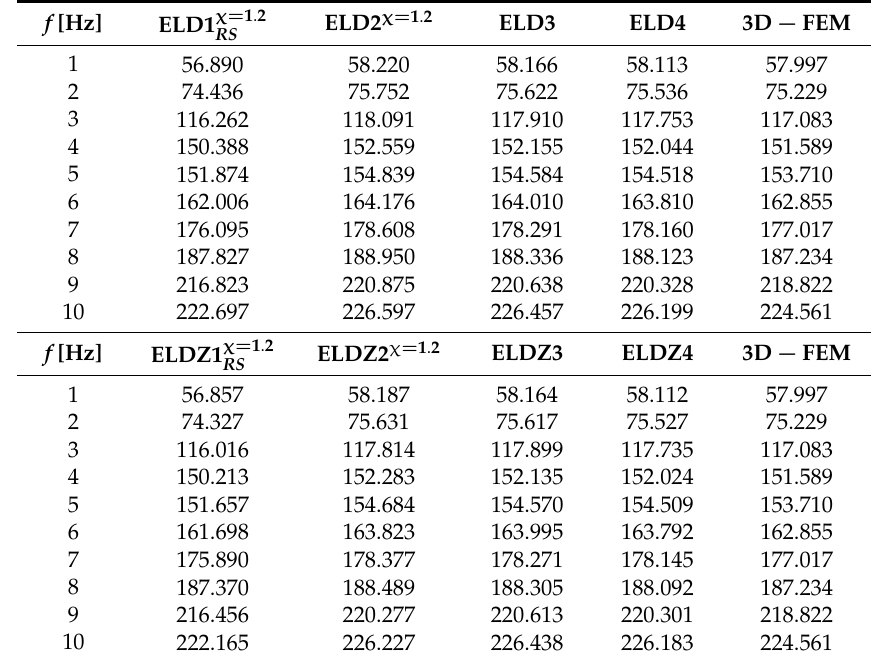
Table 7. First 10 natural frequencies ([Hz]) for a CCFC laminated cylindrical surface with ( 90/30/45/60/0 ) as lamination scheme for several higher-order ELW approaches, with and without the Murakami’s function. The Cheb-Gau-Lob grid distribution is used for the numerical solution assuming I N = 31 and I M =